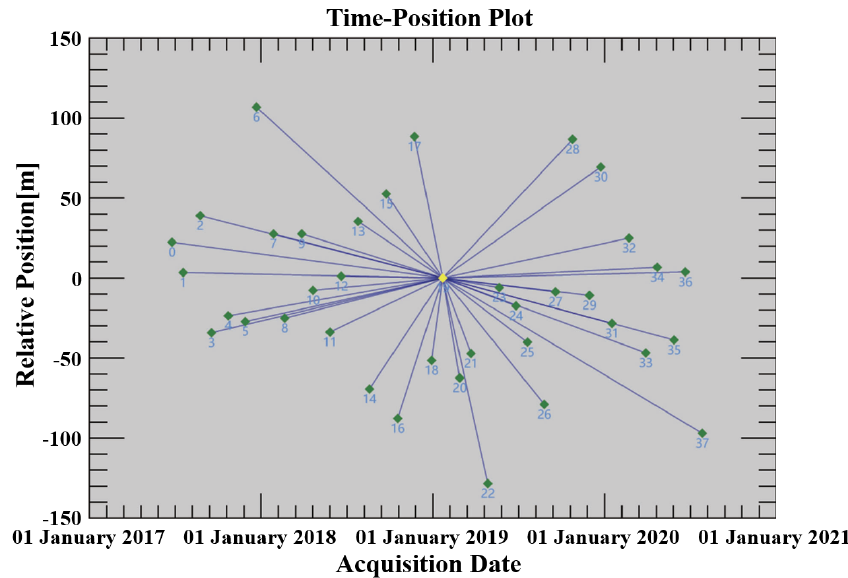
Figure 3. PS-InSAR interference processing spatio-temporal baseline distribution.